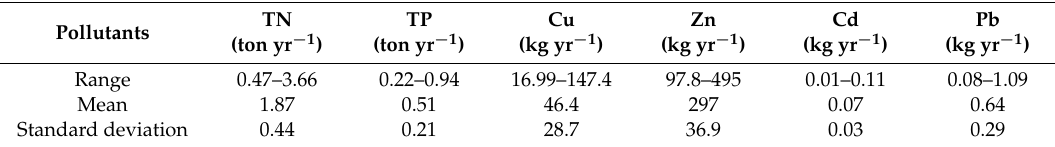
Table 4. Annual outputs of major pollutants in pig wastes discharged from sample pig